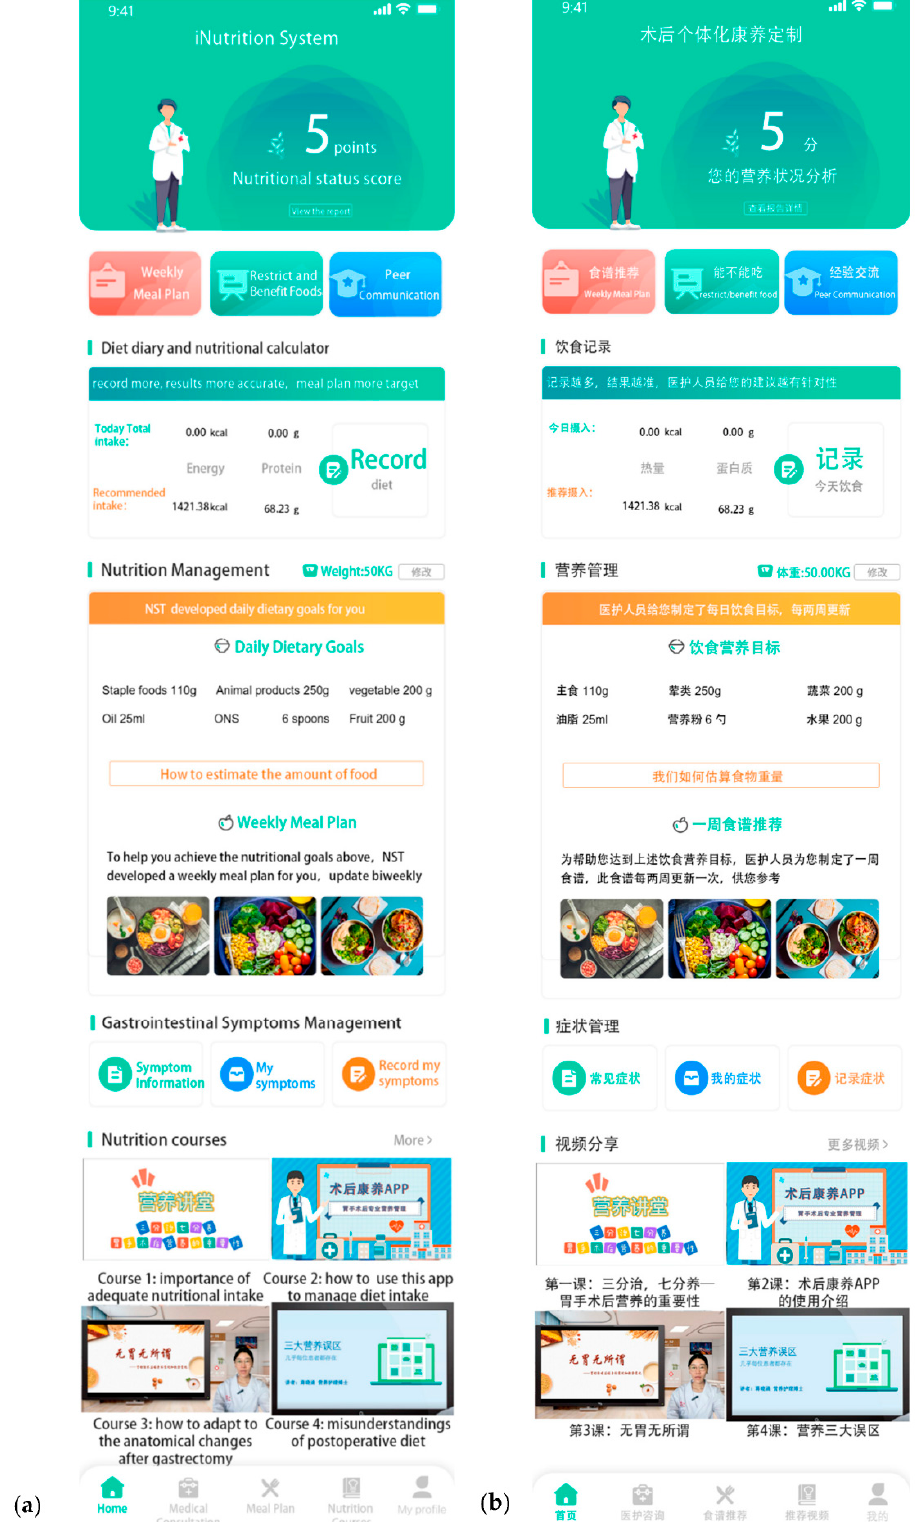
Figure 1. Screenshot of the iNutrition applet. ( a ) English version, ( b ) Chinese version.